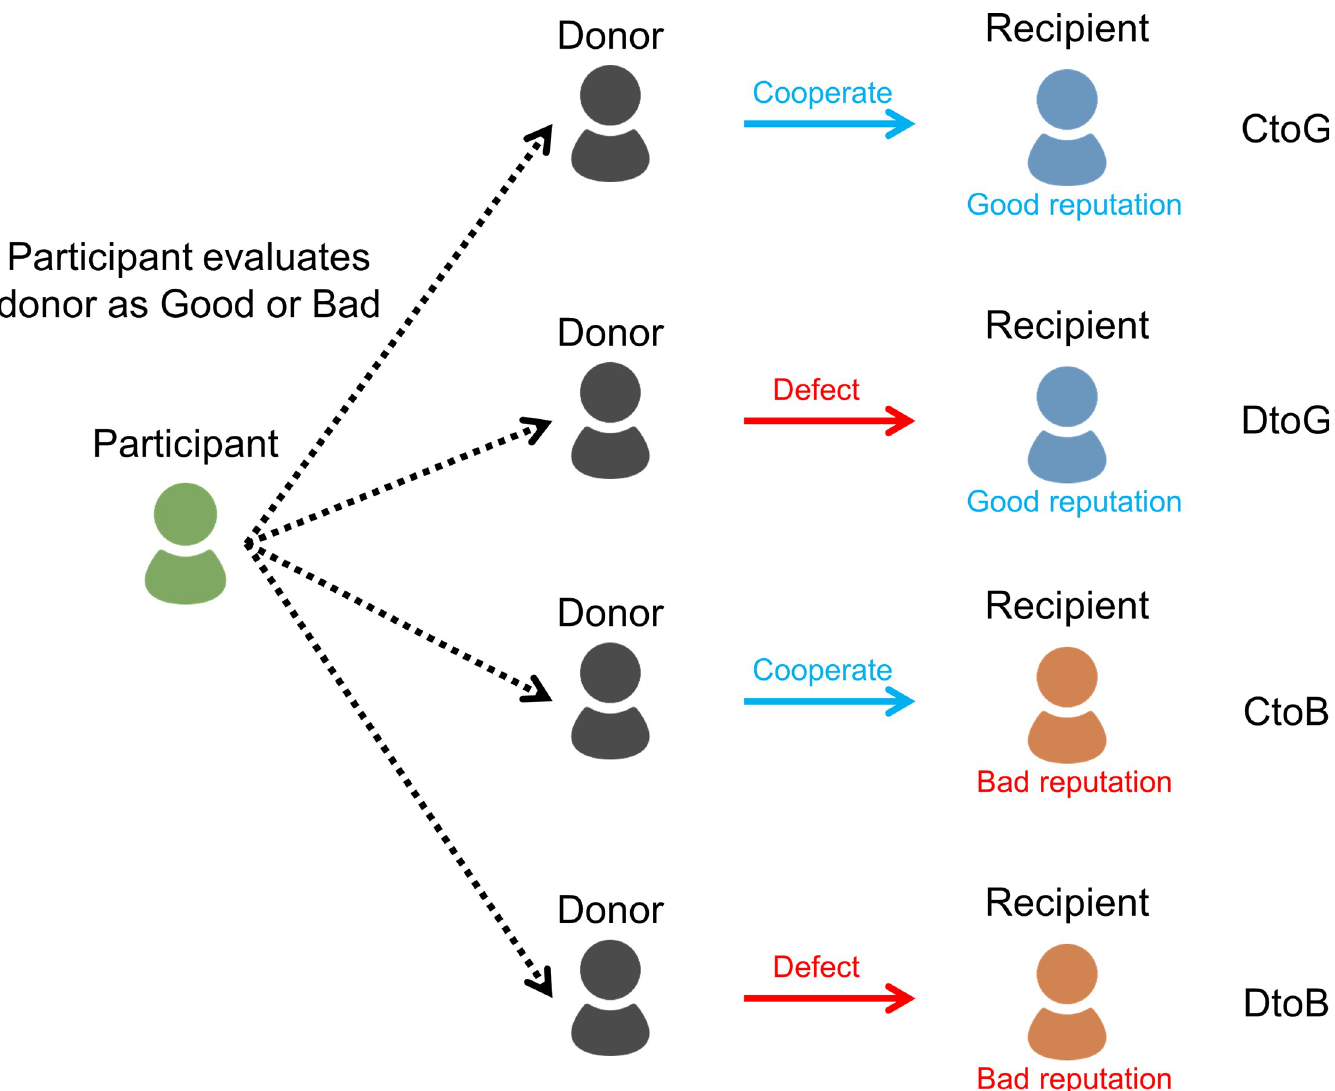
Fig 1. Overview of the experiment: Participants evaluate four scenes that consist of a combination of donor behavior (cooperate / defect) and recipient reputation (good / bad).